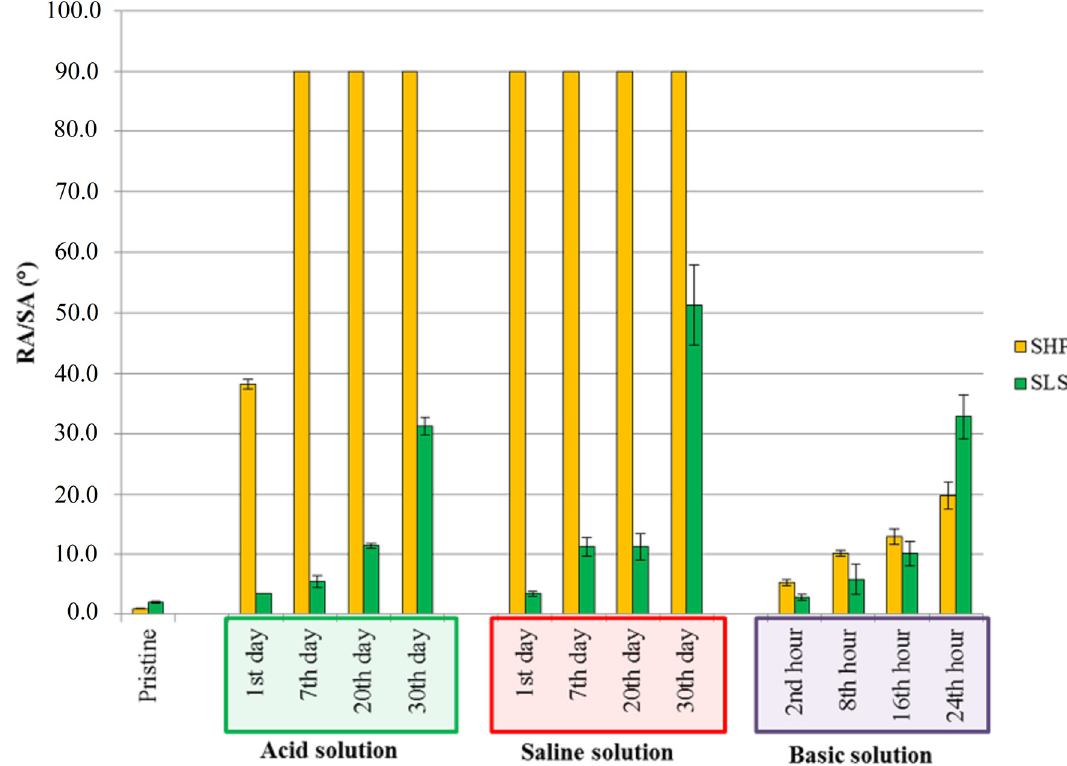
Figure 8. Roll-off/slide-off angles of SHP and SLS after aging in acid, saline and basic solutions: values of 90° mean that the drops did not roll off.